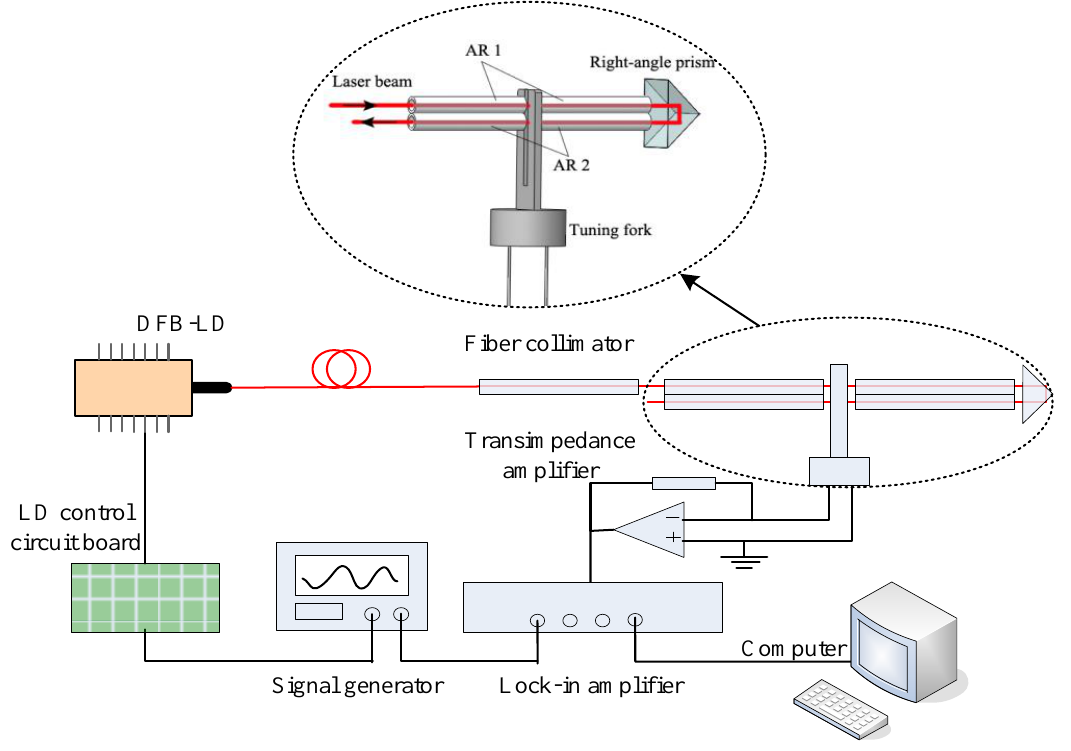
Figure 1. Schematic of the QEPAS system with a right-angle prism.